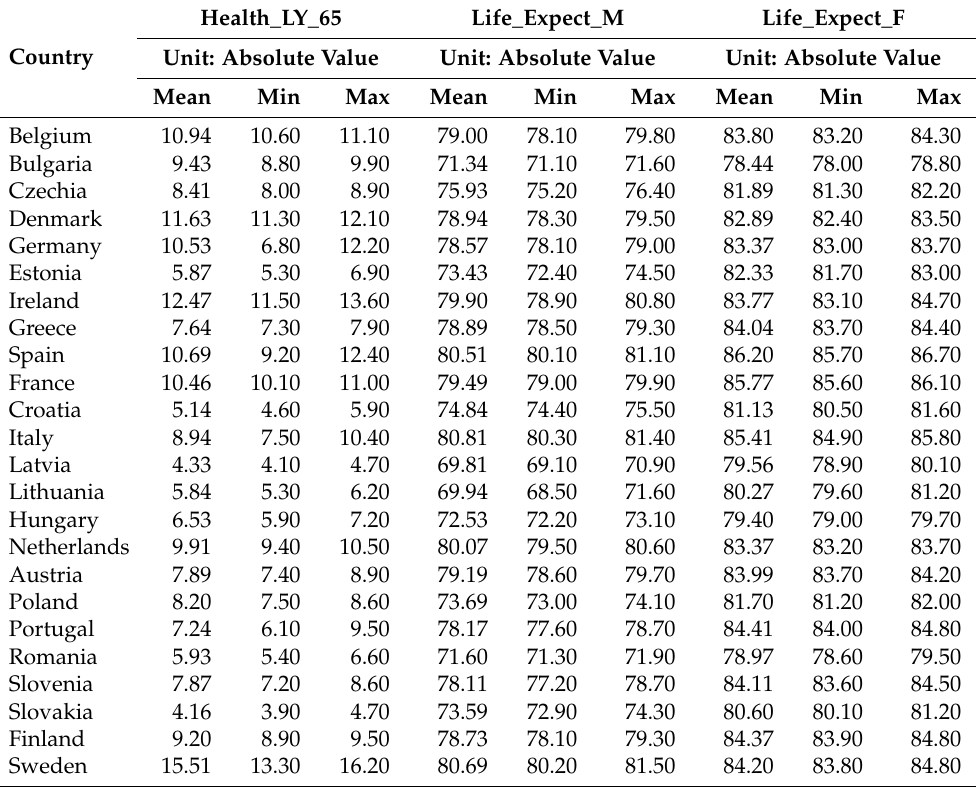
Table 2. Descriptive statistics of the